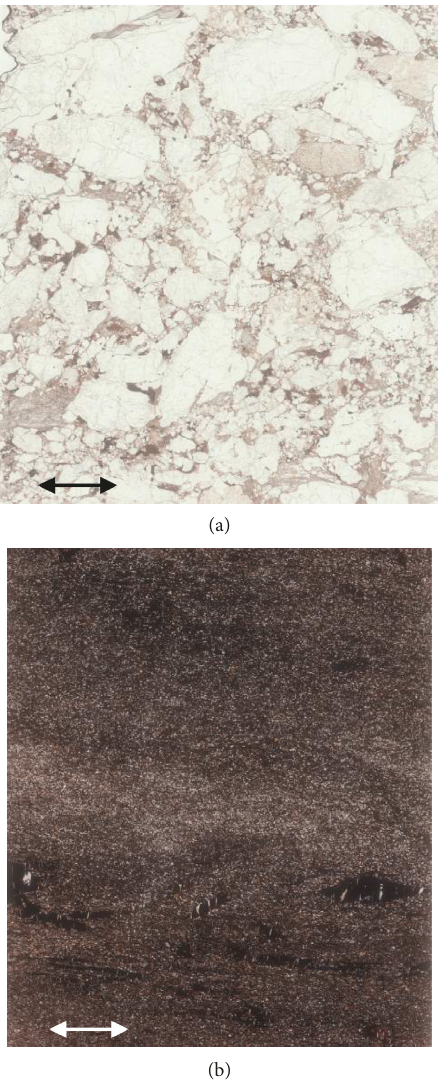
Figure 10: Scanned thin section images. The arrow length is 2.5mm. (a) Kaziwiziwi conglomerate. (b) Kaziwiziwi carbonaceous